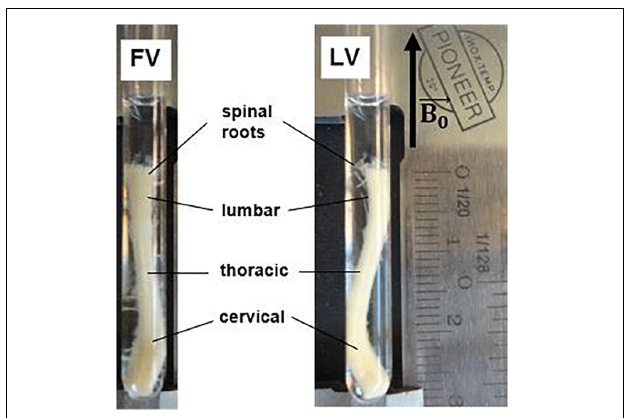
FIGURE 1 | Excised mouse spinal cord in a 5 mm glass capillary for MRI examination. The specimen is about 2.6 cm in length, with maximum cross section of 4 mm × 2.5 mm at the level of the cervical and lumbar enlargements. Different tracts of the spinal cord are indicated. FV = frontal view, LV = lateral view. Black arrow indicates static magnetic field